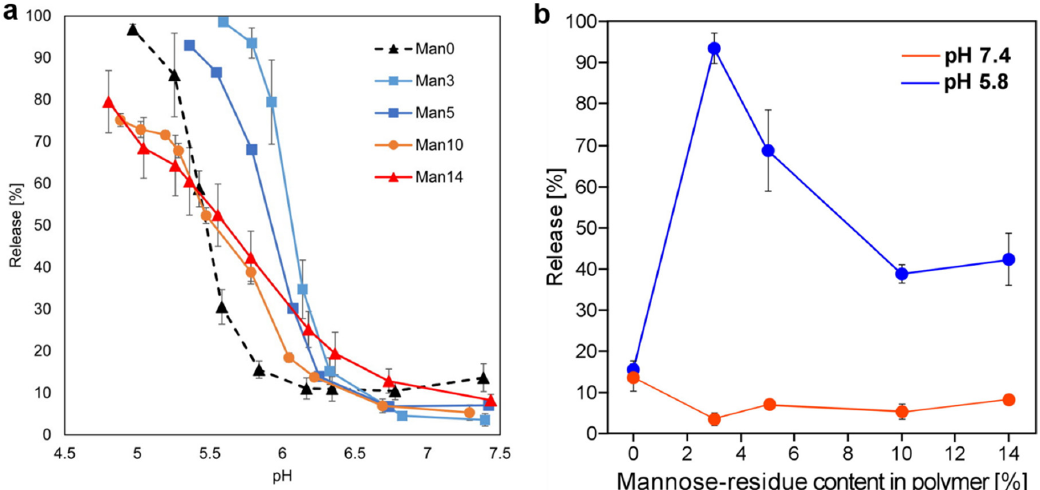
Figure 2. ( a ) pH-Dependence of pyranine release from curdlan derivative-modified liposomes at 30 min. ( b ) Content release from liposomes as a function of mannose-residue contents at pH 7.4 and pH 5.8.